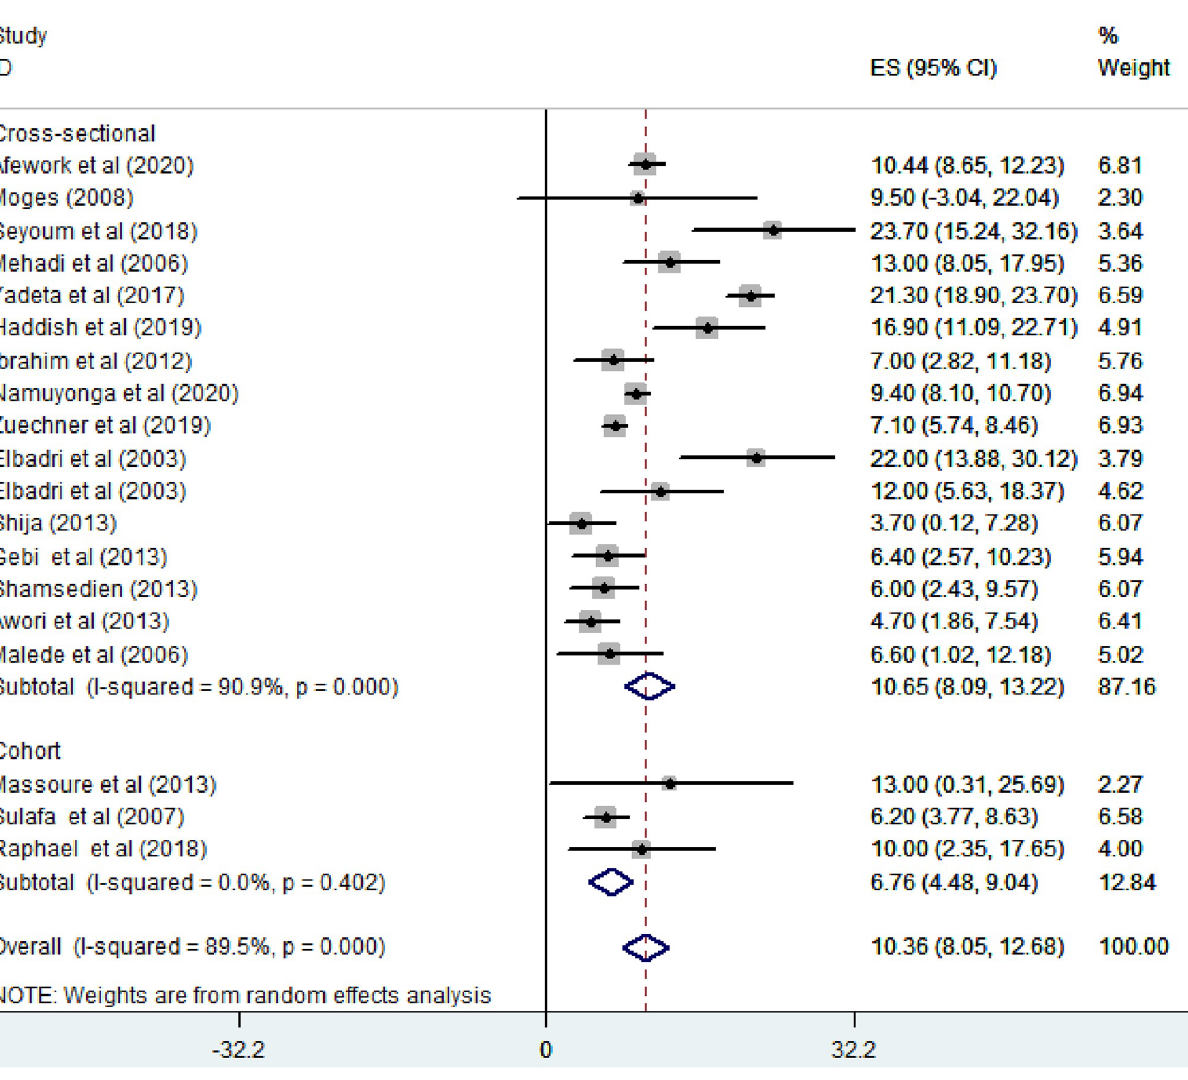
PLOS ONE | https://doi.org/10.1371/journal.pone.0250006 April 22,